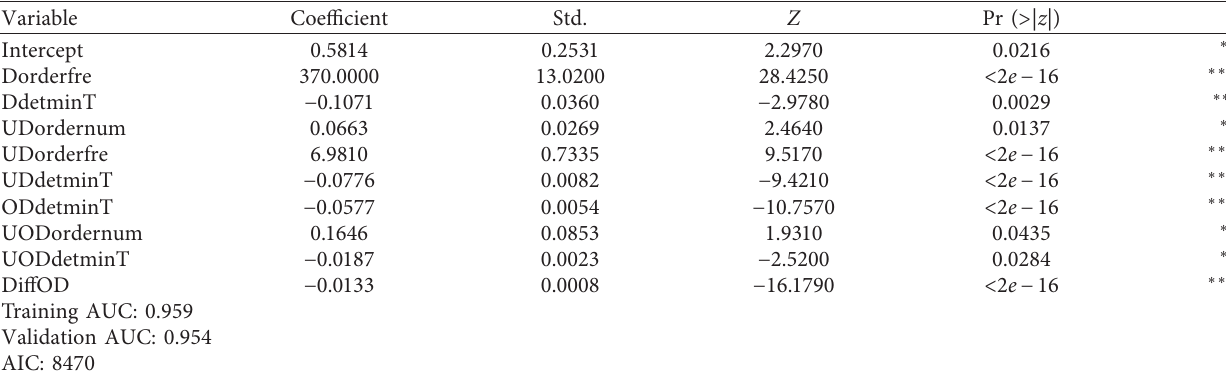
Figure 6: The distribution of selected stations. Table 3: Demand time prediction